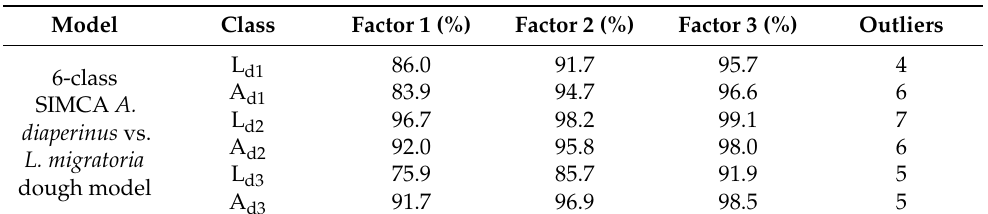
Table 6. The number of factors, their cumulative variance, and the number of outliers used to create a 6-class SIMCA model of A. diaperinus vs. L. migratoria dough.